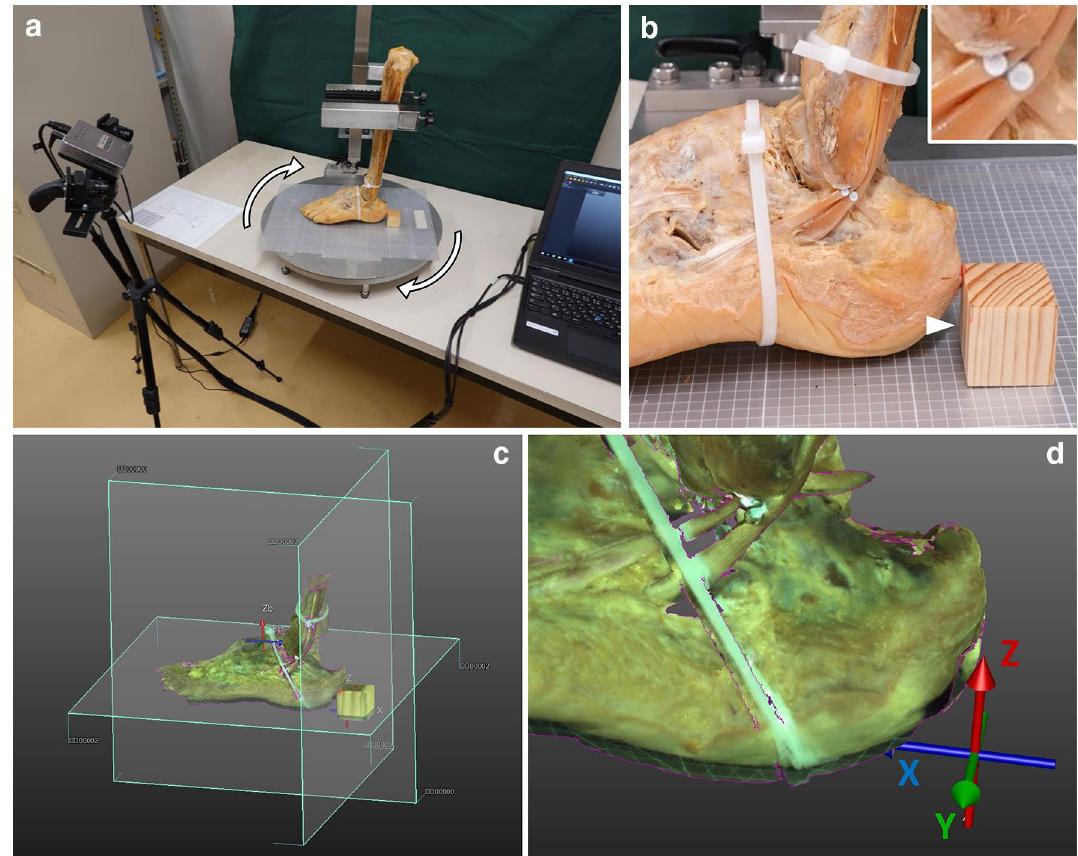
Figure 2. Three-dimensional scanning method and definition of the x–y–z coordinate system. ( a ) Overview of the contactless three-dimensional (3D) optical scan system used in this study. The sample is firmly sandwiched by the arms of a fixing apparatus, which is set on an automatic turntable to allow rotation during scanning (white arrows). ( b ) To detect fine positional changes, two metal pins (inset) are inserted into both tendons at the point that intersects with the calcaneofibular ligament. A corner (white arrowhead) of a wooden cube, which contacts the floor of the fixing apparatus, is set as the origin coordinates. Two plastic bands are substituted for the superior and inferior fibular retinaculum. ( c , d ) 3D visualization of the scanned data based on the x–y–z coordinate system. The x -axis is defined as the straight line connecting the center of the posterior surface of the calcaneus and the point at the mid-second/third metatarsal heads; the z -axis indicates the vertical All samples were scanned under three conditions with 360° rotation. First, the sample was positioned with the talocrural and subtalar joints in the 0° position to evaluate the CFL running angle. Second, to investigate the effect of the increased tension of the CFL, the samples were wrapped with two plastic bands at the position of the superior and inferior fibular retinaculum to keep both tendons at their original running site (Fig. 2b) and set in the inversion 15° and plantar flexion 10° positions. This condition was defined to tense the CFL with inversion 7 and avoid overstretching the PLT and PBT with plantar flexion. As a scanning marker, a metal flat head pin was inserted into each tendon at the point that intersects with the CFL (Fig. 2b). Third, as a control study, the CFL of the samples was detached at the calcaneal insertion after the second scanning but without removing the sample from the apparatus to avoid misalignment of the coordinate system. Measurement methods. Using the scan data, 3D models were created using IDEA 1.1 SR 8 standard ver. (Open Technologies SRL). The centers of the pinhead were specified as the positional coordinates, and distances from the origin’s coordinates were automatically calculated using WorkXPlore 2019 R1 (Vero Software, Chelten- ham, England) on the x- , y -, and z -axes independently (Fig. 3a). The CFL running angle, created by the long axes of the CFL and fibula 5 , was also evaluated (Fig. 3b). For this measurement, the fibular long axis was determined by connecting the two midpoints set by measuring the width of any region in the diaphysis. The length and width of the CFL were measured before scanning with the talocrural and subtalar joints at the 0° position and with the peroneal tendons displaced. The length was defined as the distance between the fibular origin and most proximal insertion on the calcaneus (Fig. 3c) 4,13 , whereas the portion that intersected with the PLT and PBT was defined as the width (Fig. 3d). A caliper (Fujiwara Sangyo, Hyogo, Japan) with a 0.5-mm mini- mum recording unit was used for the measurements. The accuracy of the technique was confirmed by repeating